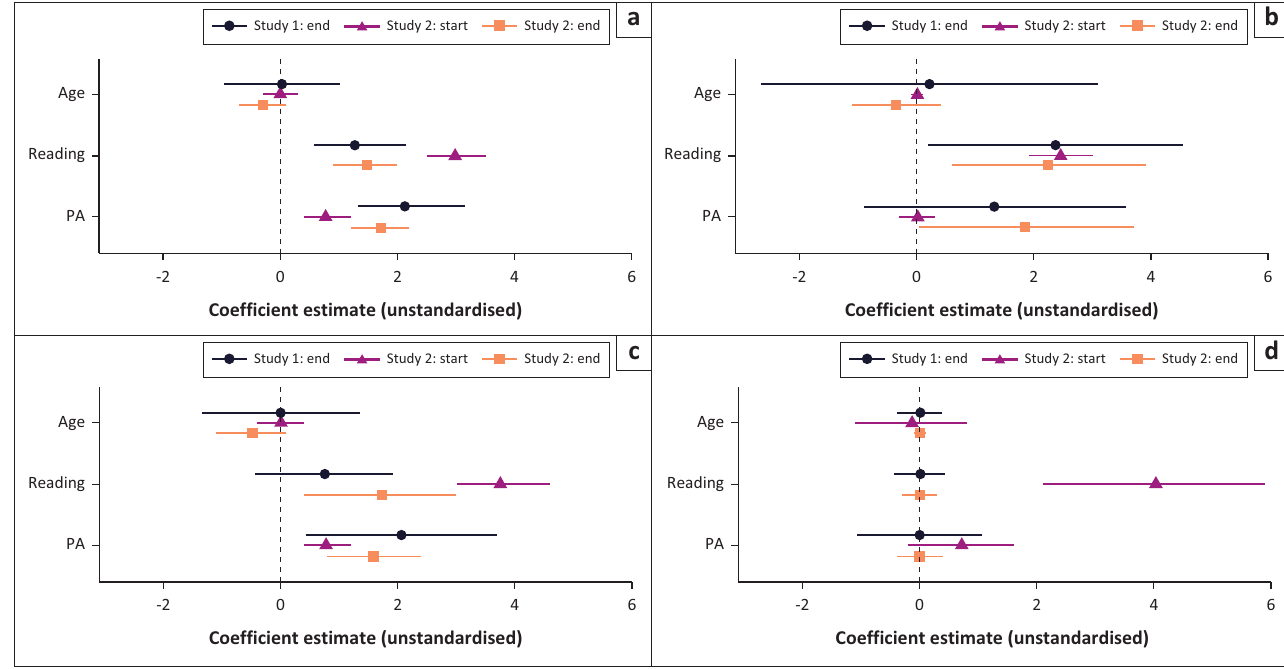
FIGURE 1: Model coefficients with 95 % confidence intervals for linear and quantile regressions for study 1 (end of Grade 3) and study 2 (start and end of Grade 3). (a) Linear Regression; (b) Quantile Regression: tau = 0.10; (c) Quantile Regression: tau = 0.50; (d) Quantile Regression: tau =